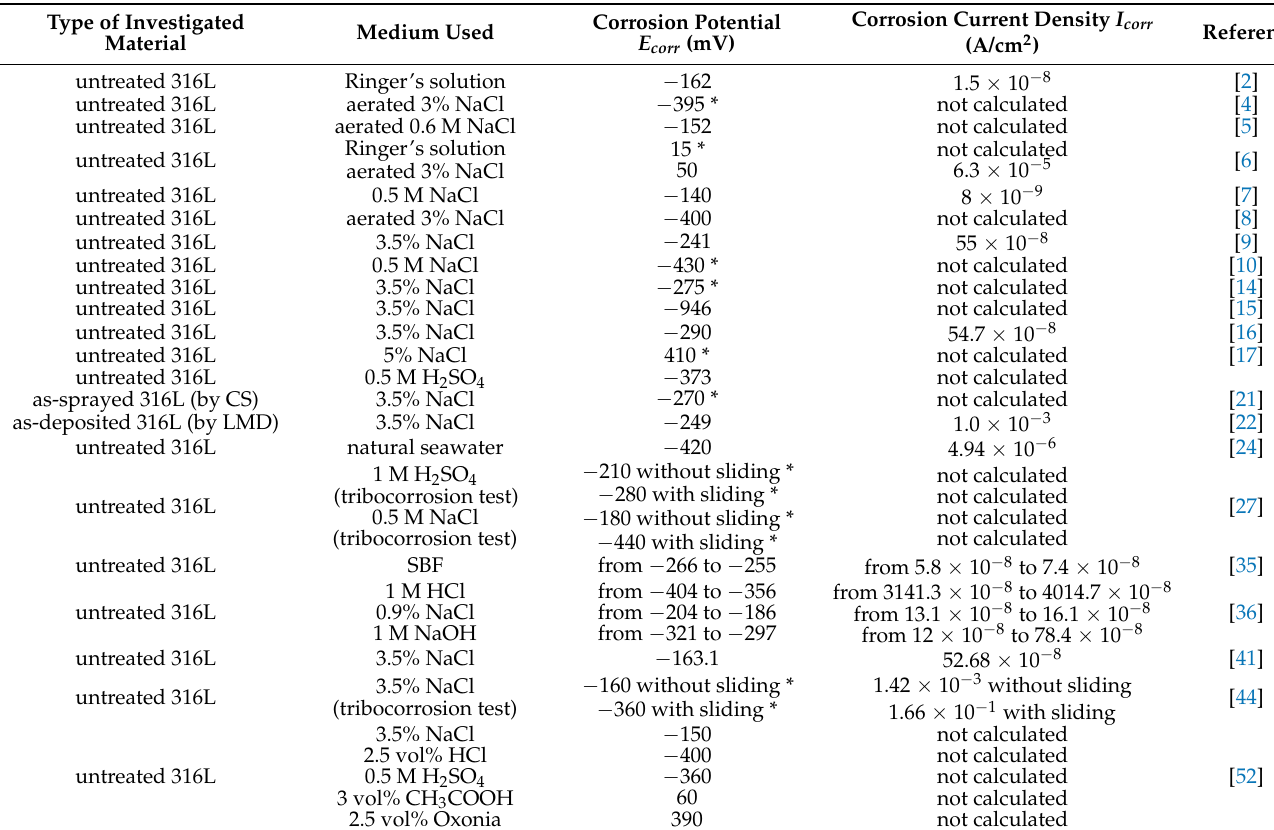
Table 9. Corrosion potential E corr and corrosion current density I corr of the untreated, as-sprayed and as-deposited austenitic 316L steels based on the other